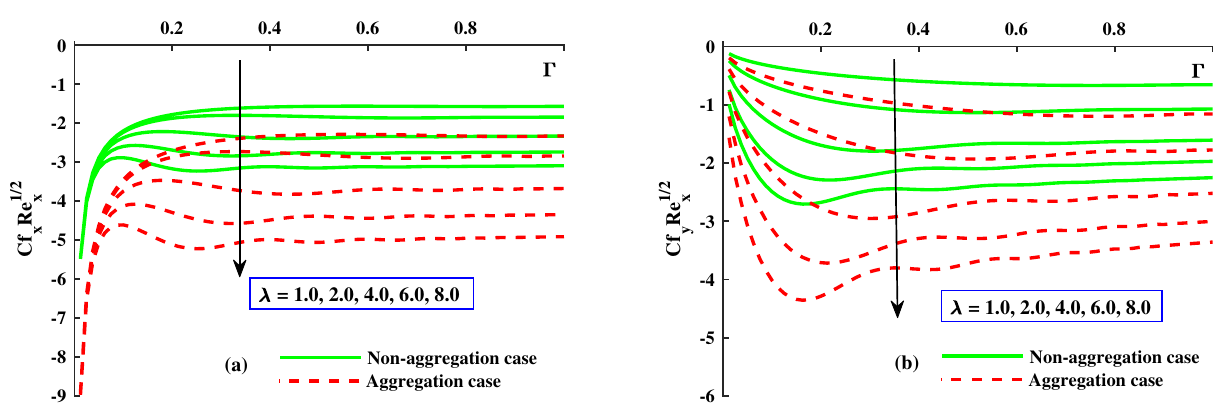
1 / 2 x in x-direction, and Cf y Re